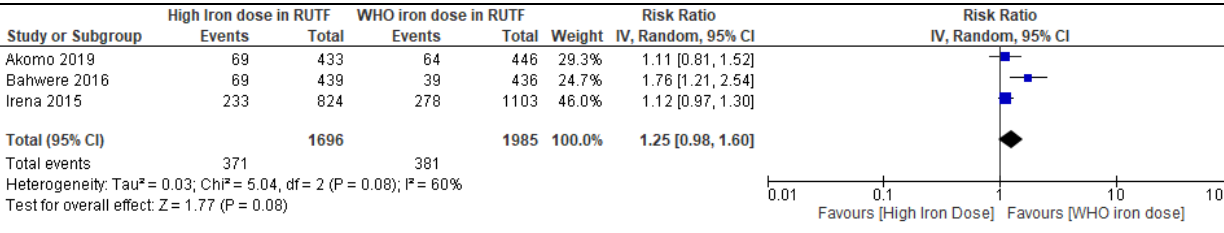
Figure 8. Effect of SMS-based RUTF with high iron content compared to that of peanut-based RUTF with WHO standard iron content on default from trial. The forest plot shows pooled data from all three included studies from this review. Raw values were used, and an intention-to-treat analysis was preferred, where available. The pooled results show a potential increase in default rate for children receiving RUTF with high iron content compared to RUTF with WHO standard iron content. Akomo 2019 [4]. has two study groups. We included data from milk-free soybean,